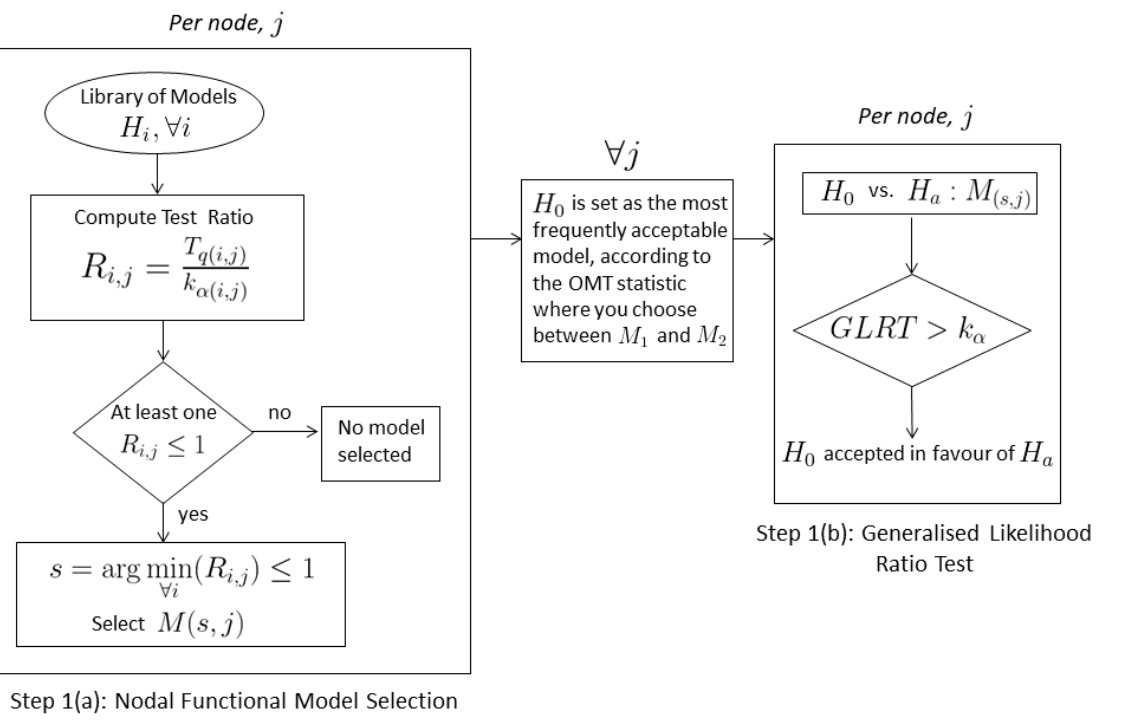
Figure 4. Testing procedure for the functional model selection using time series per grid